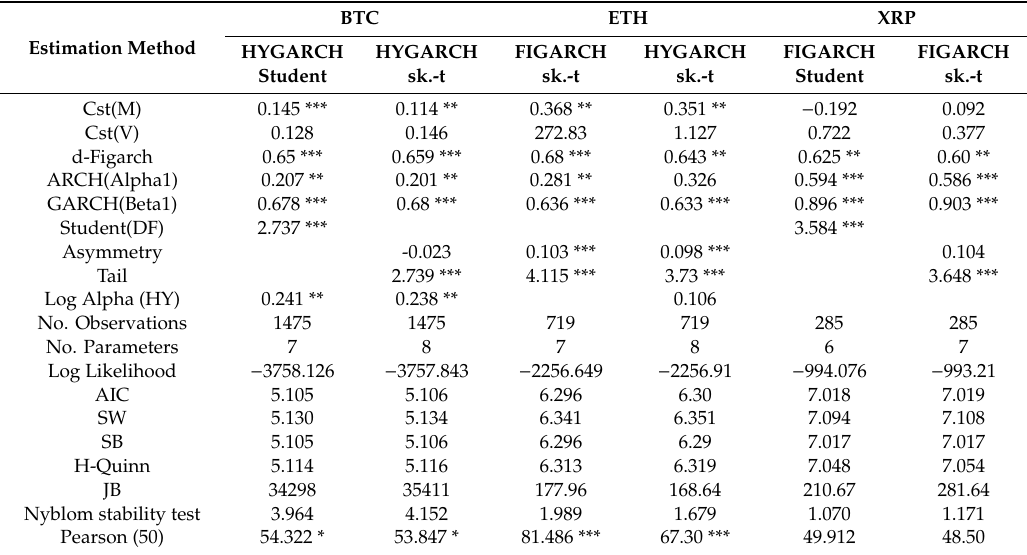
Table 5. Estimation Results of Bitcoin, Ethereum, and Ripple